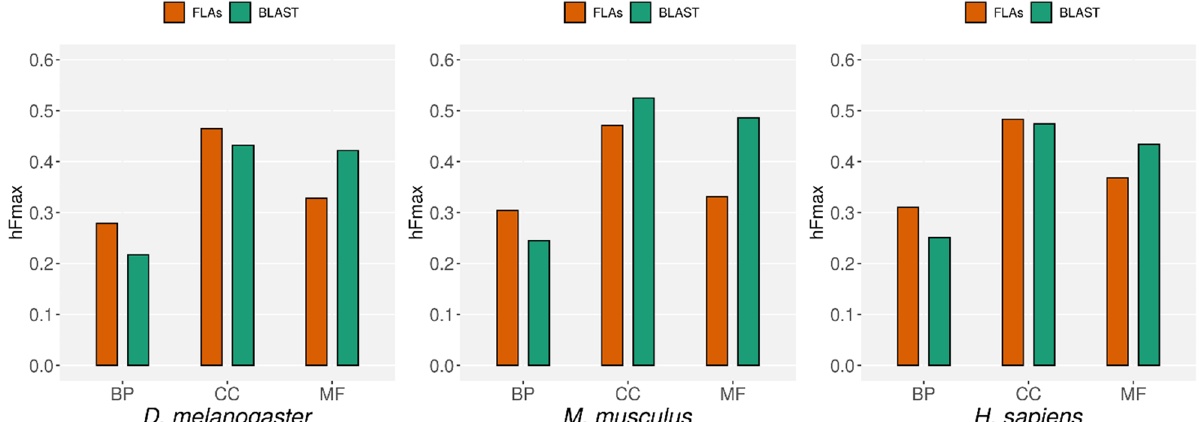
Figure 6. Comparison to one of the CAFA baseline methods. Each graph shows the hFmax of different models when predicting GO terms of the three ontologies in three organisms. In red, the hFmax of the models exclusively trained with FLAs, evaluated using the new experimental annotations accumulated from November 2018 to September 2021. In green, the hFmax of BLAST when making predictions on the same organisms and ontology as reported in CAFA 3 7 .